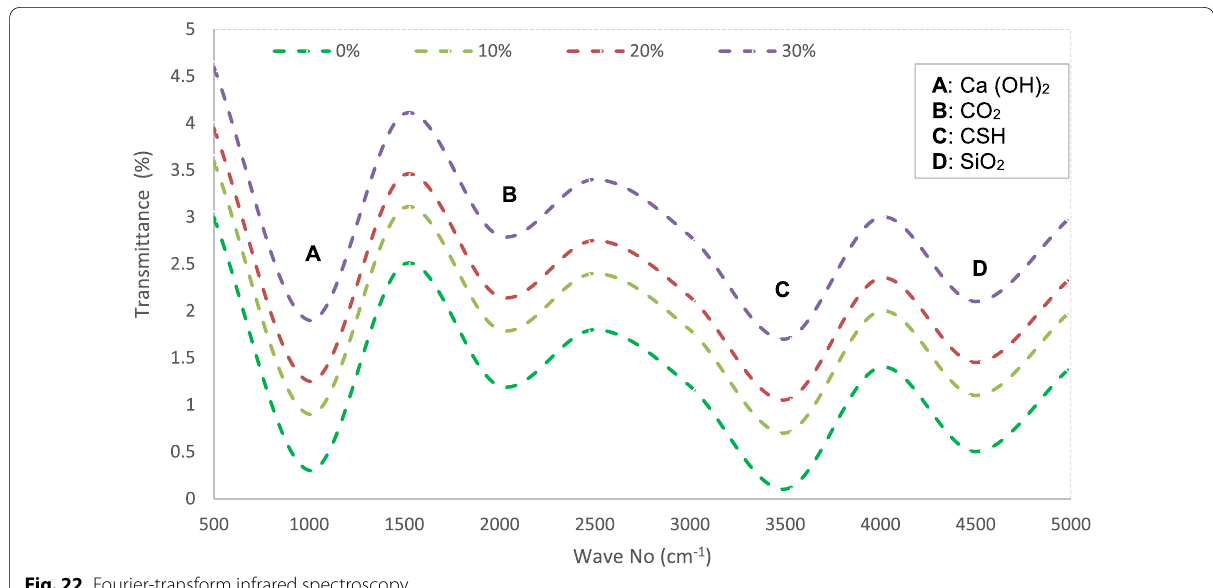
Fig. 22 Fourier‑transform infrared spectroscopy.